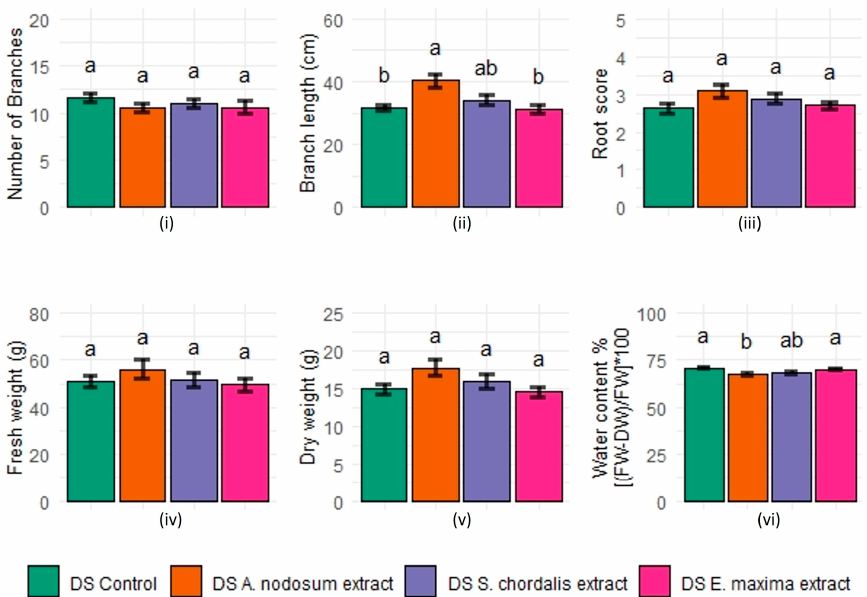
Figure 1. Effect of seaweed-based biostimulants on morphological parameters of Hydrangea paniculata under deficit irrigation (DS) (DS Control = non-treated deficit irrigation). ( i ) number of branches, ( ii ) length of the longest branch, ( iii ) root development score, ( iv ) fresh and ( v ) dry weight, ( vi ) plant water content. Fresh weight and water content were analyzed by a two-way ANOVA and a Tukey HSD test, the other parameters by a Scheirer–Ray–Hare test followed by a Dunn’s test. Different letters (a and b) per parameter indicate a significant difference at p ≤ 0.05 (Mean ± SE, n = 24).